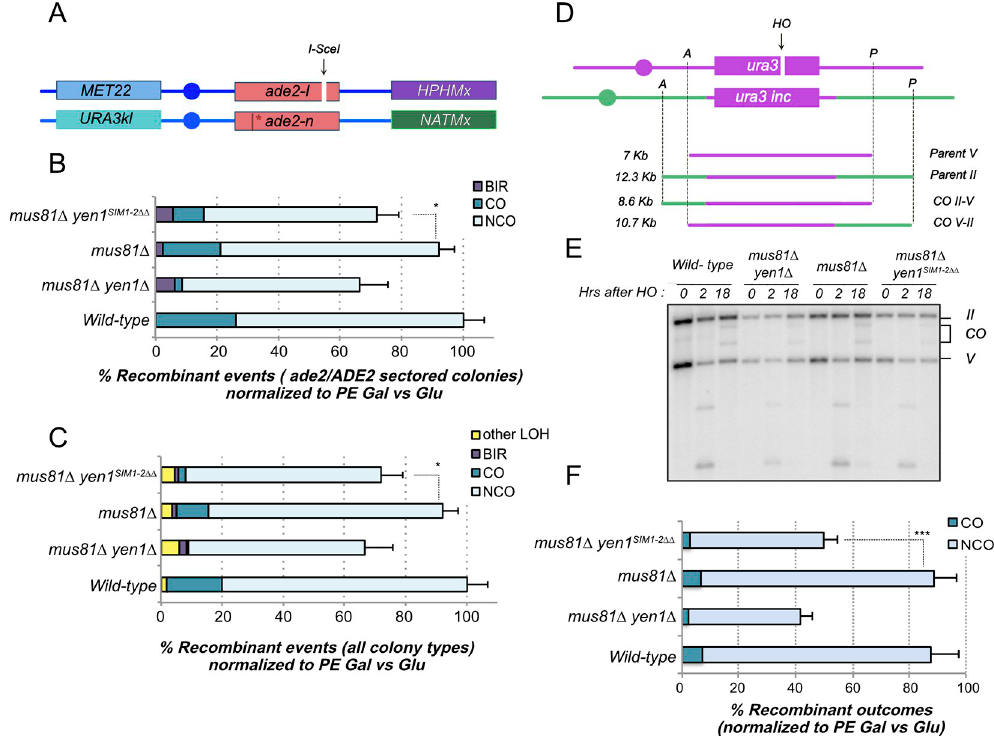
Fig 6. Crossover formation is impaired in cells containing the mutant version of Yen1 inactivating both SIMs in a mus81 Δ background. (A) Diagram showing the chromosome XV based DSB-induced recombination reporter. (B) Recombination outcomes in red-white (ade2/ADE2) sectored colonies of the indicated strains, normalized to their Plating Efficiency (PE) in galactose compared to glucose. (C) Recombination outcomes combining the results obtained for all types of colonies (full red, full white and sectored) of the indicated strains, normalized to their Plating Efficiency (PE) in galactose compared to glucose. Statistical significance for B and C was determined by the Chi-square test at P < 0.05, see S10 Table. (D) Diagram showing the chromosome II-V based ectopic DSB-induced recombination reporter and its expected outcomes during physical analysis. (E) Representative southern blot analysis of the indicated strains after genomic DNA digestion with the restriction enzymes as highlighted in diagram D and hybridization with a radiolabeled probe against the URA3 locus. (F) Quantification of at least three independent southern blot analyses is plotted relative to PE (galactose vs glucose). Statistical significance was determined by the Student T-test at P < 0.05, see S11 Table.